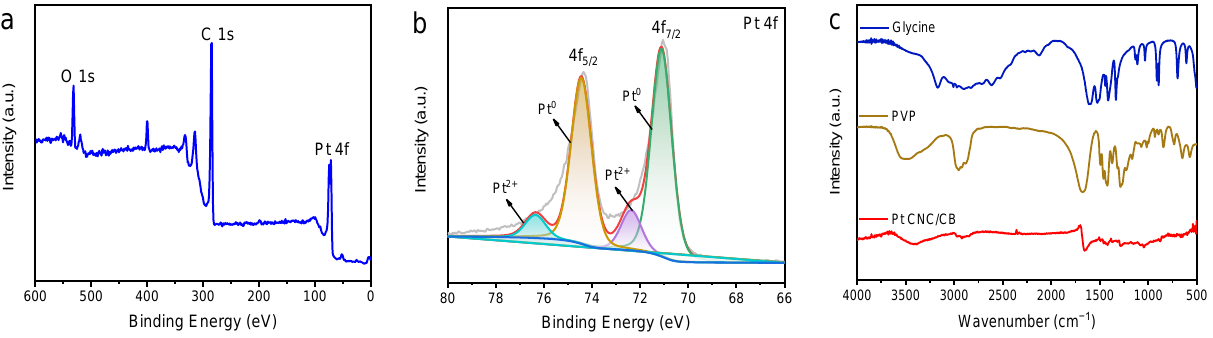
Figure 3. XPS survey spectrum of Pt CNC/CB ( a ); high-resolution XPS spectrum of Pt 4f ( b ); FT-IR spectrum of Pt CNC/CB, PVP, and glycine ( c ).